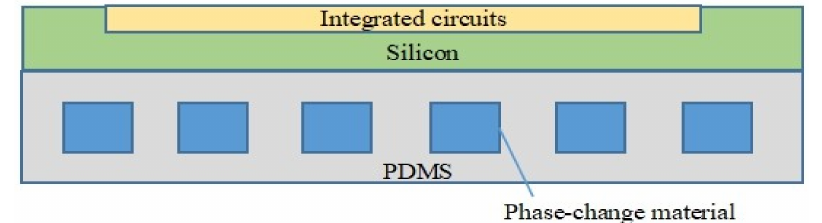
Figure 1. A schematic diagram of the polydimethylsiloxane (PDMS) based microfluidic device filled with phase-change material for chip cooling in integrated circuits.